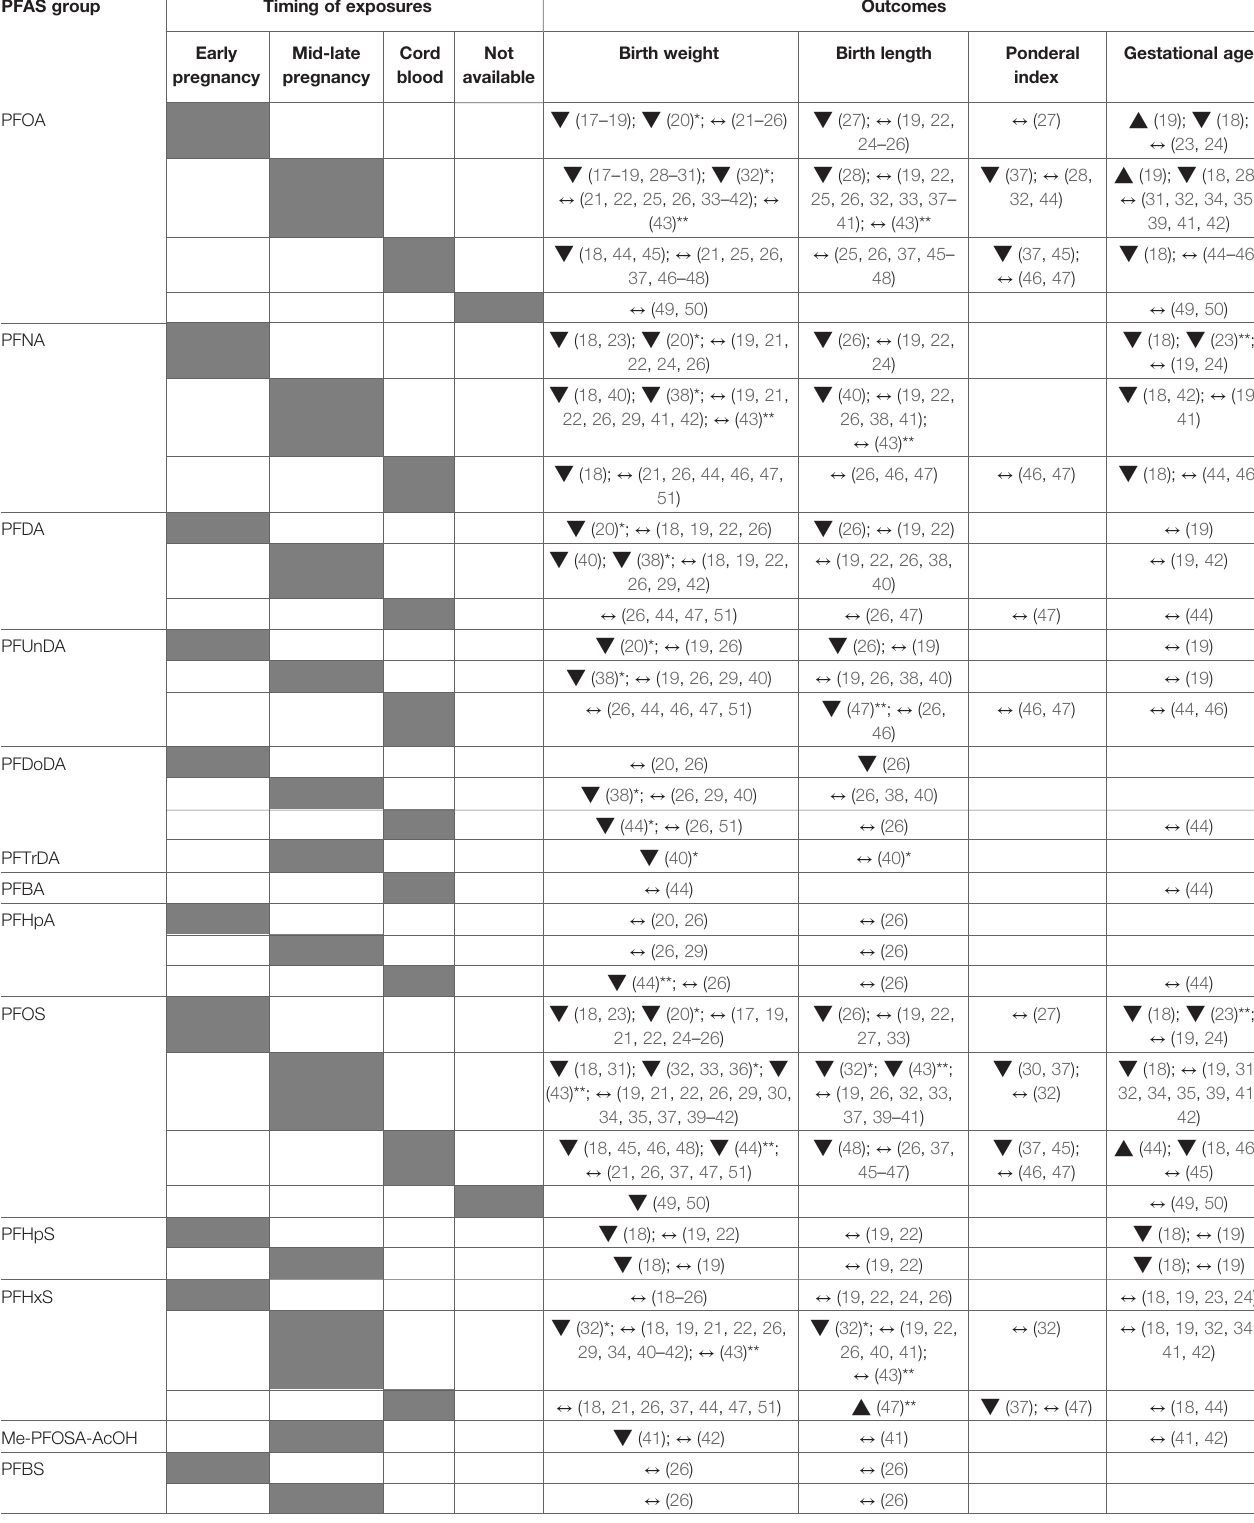
TABLE 1 | Summary of studies assessing associations between prenatal PFAS exposure and fetal growth. PFAS